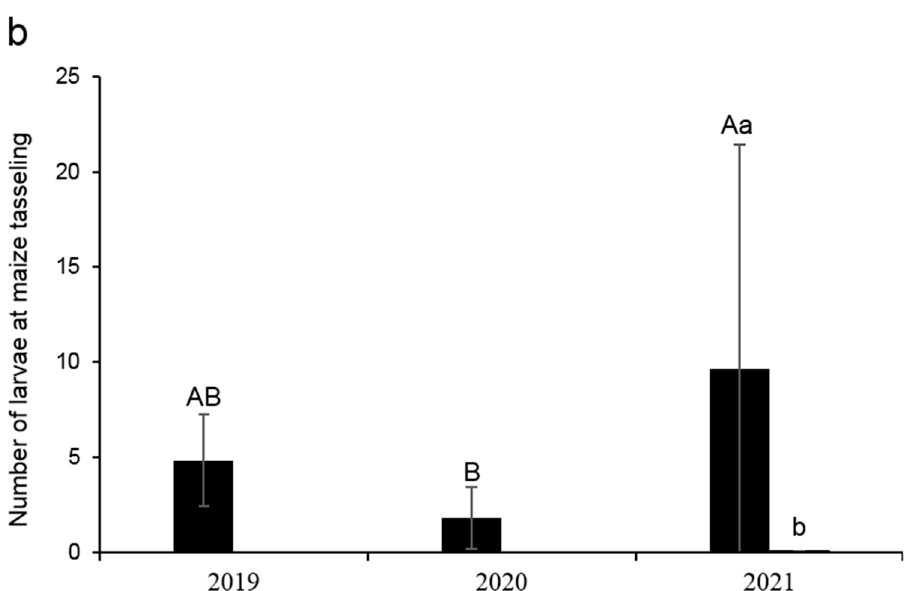
Figure 4. Mean number ( ± SE) of Spodoptera frugiperda (FAW) and Helicoverpa armigera (CBW) adults ( a ) or larvae ( b ) on maize at the tasseling stages in 2019–2021. Different capital letters above error bars indicate significant differences in the number of FAW or CBW among years; different lowercase letters indicate significant differences in the number of adults or larvae between FAW and CBW in the same year.